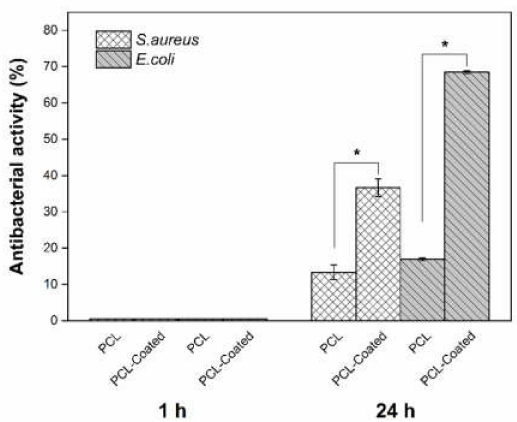
Figure 12. Histograms of antibacterial assay against two bacterium strains for pristine PCL and coated sca ff olds after 1 h and 24 h. (One-way ANOVA analysis indicated a statistically significant di ff erence between the antibacterial activity of coated samples in comparison with uncoated ones after 24 h, * p < 0.05, n =